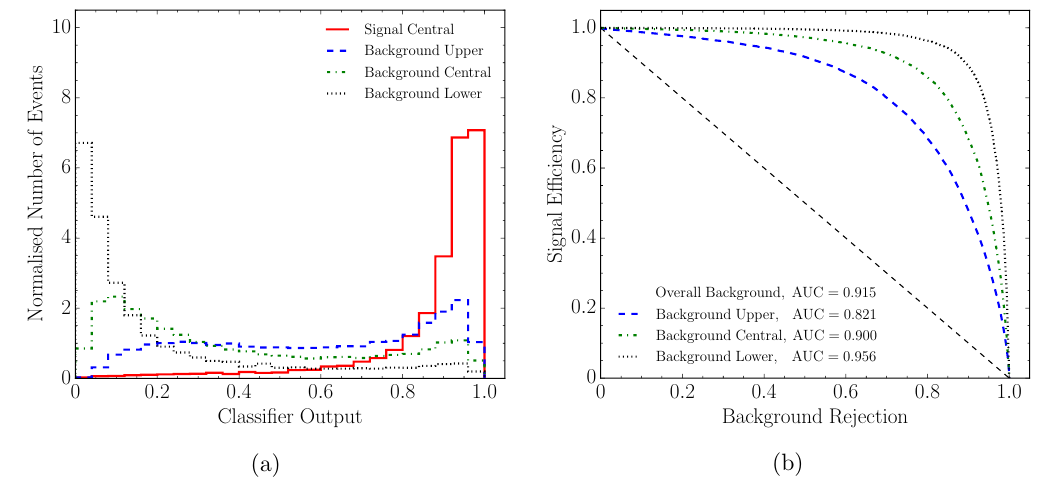
Figure 2. Supervised neural network classi(cid:12)er output (a) and ROC curves (b) for a classi(cid:12)er trained to classify signal and background events. The three background distributions result from the three di(cid:11)erent directions of